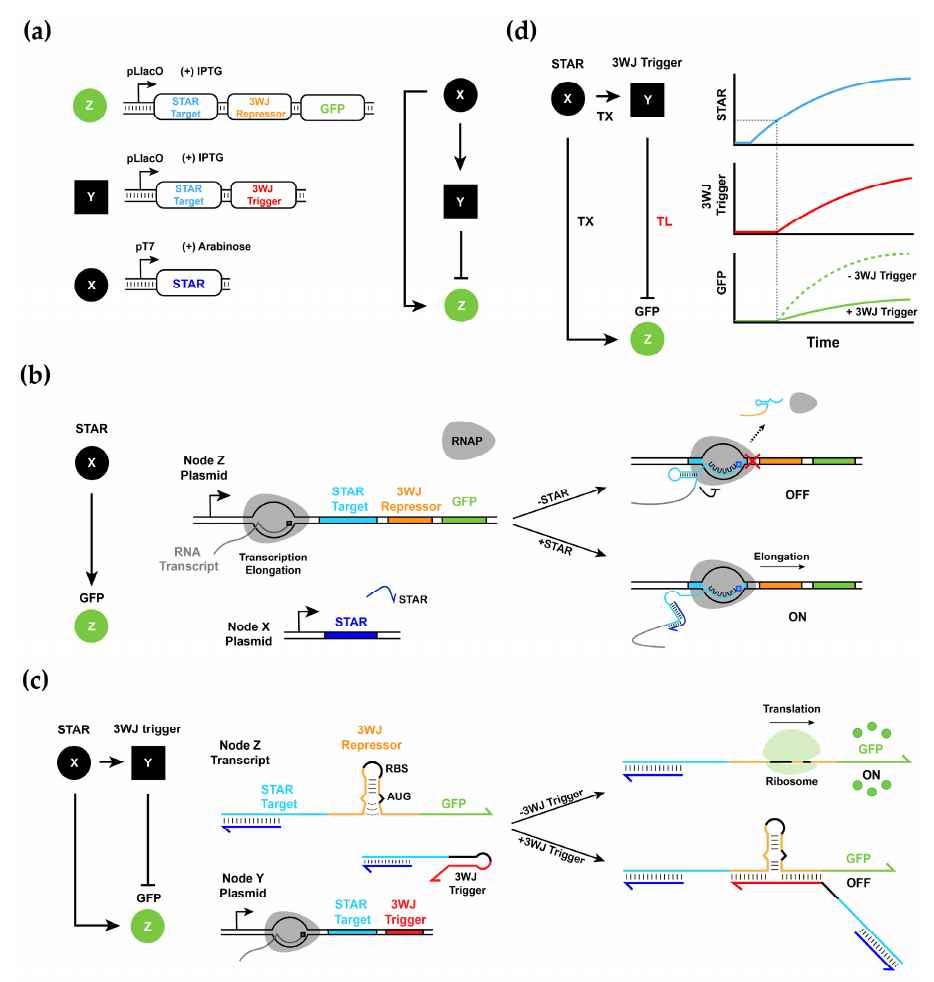
Figure 2. Architecture of RNA-only IFFL circuit composed of STAR and 3WJ repressor. ( a ) Detailed node constructs of RNA-only IFFL circuit. Node Z contains the STAR target linked to 3WJ repressor and GFP under the control of pLlacO. Node Y contains the STAR target linked to 3WJ trigger under the control of pLlacO. Node X contains the STAR trigger expressed under pT7. ( b ) Schematic of the activation by X on Z. When X binds to the STAR target of Z, terminator formation is prevented, allowing transcription elongation. ( c ) Schematic of the inhibition by Y on Z. Y, which is transcribed in the presence of X, can bind to the 3WJ repressor switch domain of Z, forming a 3WJ structure that prevents translation initiation. ( d ) Expected GFP expression profile in the presence and absence of the 3WJ trigger activated by STAR. The 3WJ trigger may be able to repress GFP expression by forming 3WJ structures with little time delay. Note, TX stands for transcription and TL stands for trans- lation.